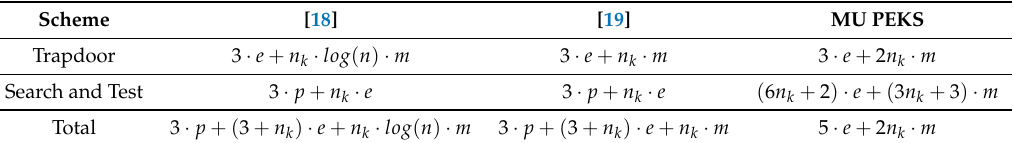
Table 7. The comparison of users’